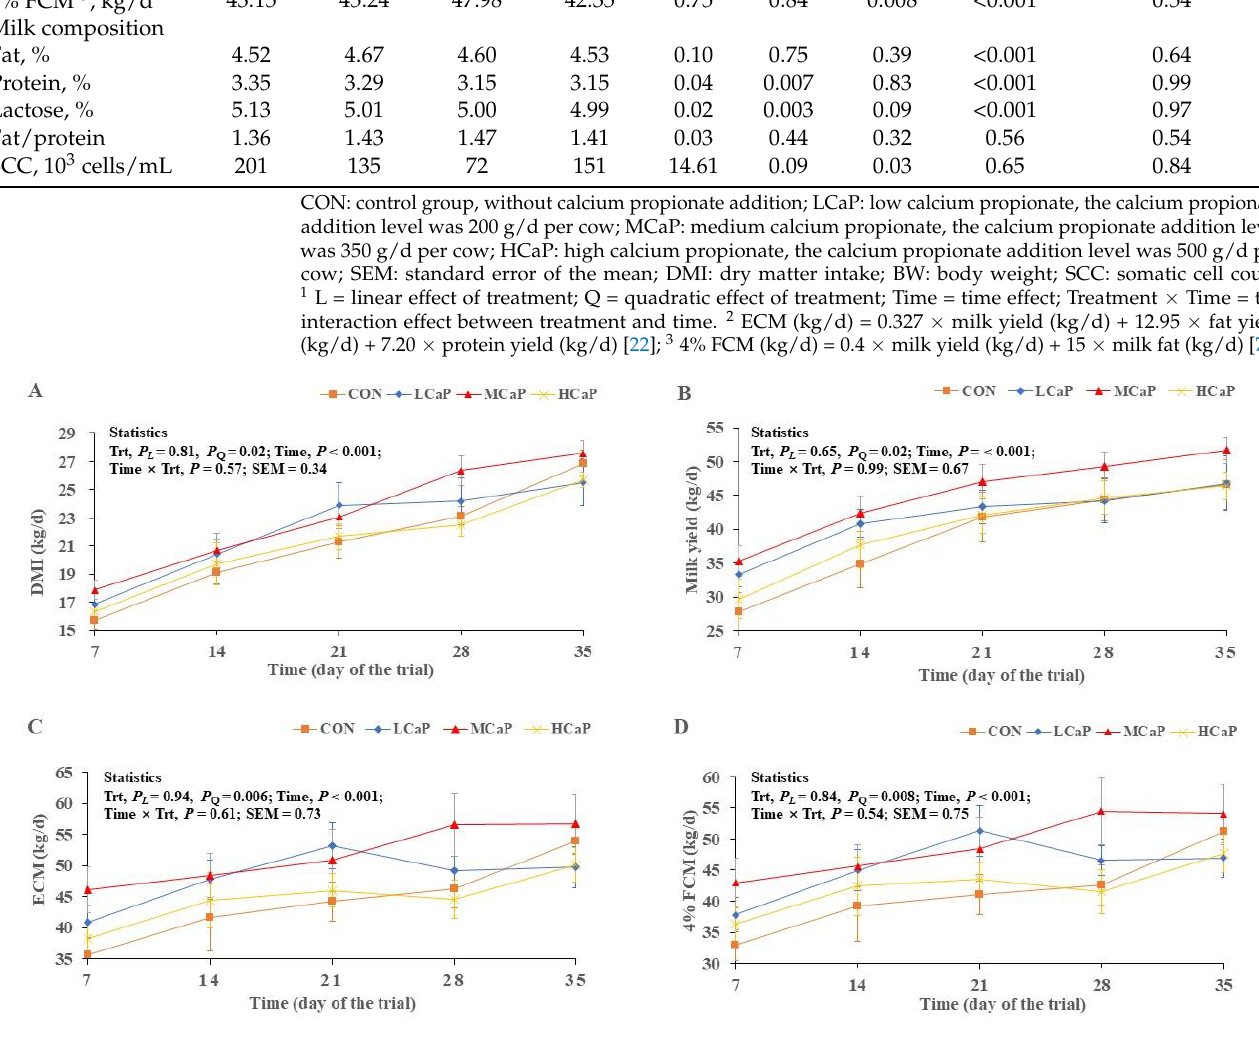
Figure 1. Dynamic changes in DMI ( A ), milk yield ( B ), ECM ( C ), and 4% FCM ( D ) after supplement- ing dairy cows with calcium propionate in early lactation. CON: control group, without calcium propionate addition; LCaP: low calcium propionate, the calcium propionate addition level was 200 g/d per cow; MCaP: medium calcium propionate, the calcium propionate addition level was 350 g/d per cow; HCaP: high calcium propionate, the calcium propionate addition level was 500 g/d per cow. Trt = treatment; PL = linear effects of the treatment; PQ = quadratic effects of the treatment; Time = time effect; Time × Trt = the interaction effect between time and treatment; SEM = standard error of the